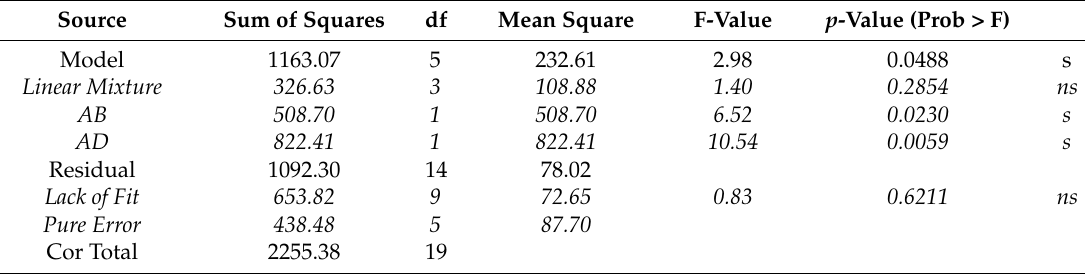
Figure 3. Model graph showing the design space and variation in particle size as a function of the mixture composition. A = Crosslinking agent; B = Initiators; C = Stabilizer and D = Macromonomer (Polylactide-based nanoparticles). Table 4. Analysis of variance table for percent yield (Poly- L -lactide-based nanoparticles).